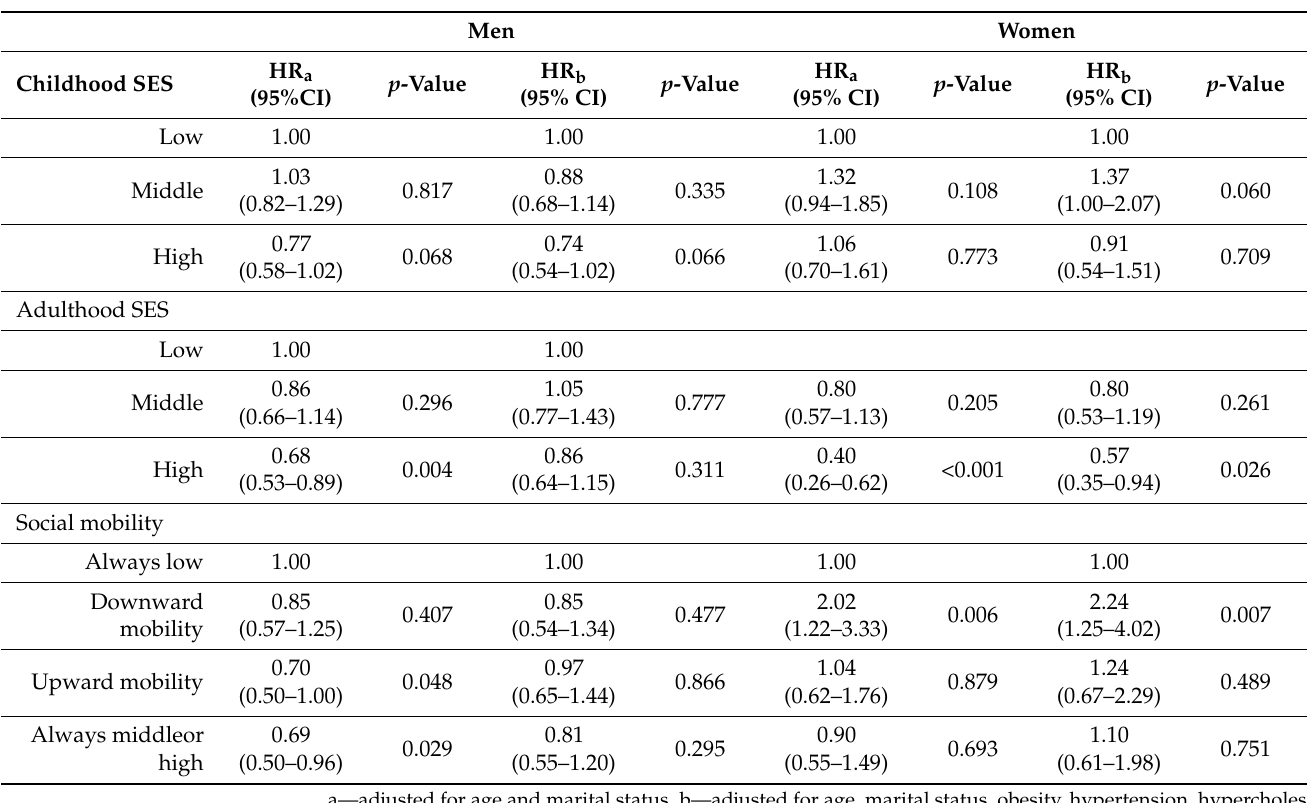
Table 2. Associations between the socioeconomic status index and cardiovascular disease incidence. Men Women